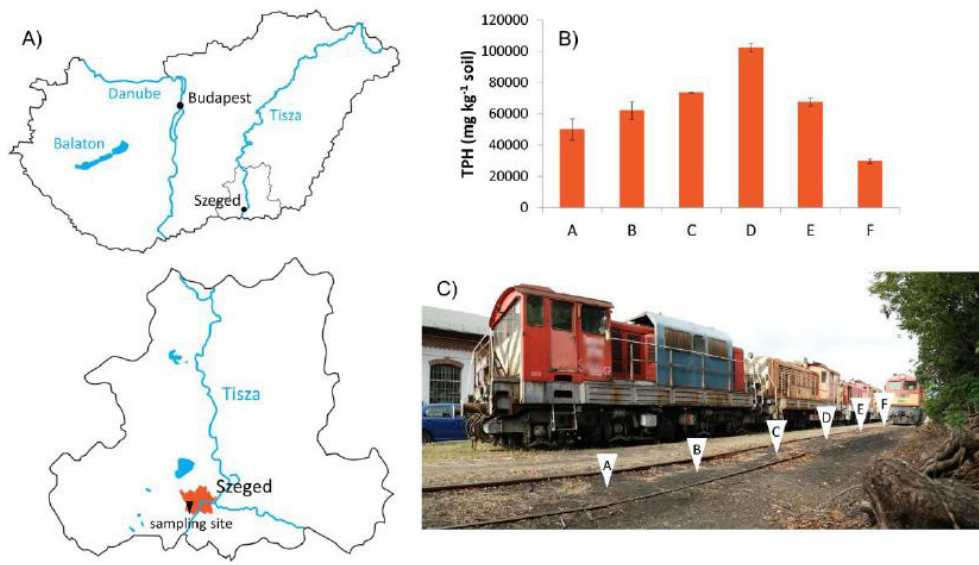
Figure 1. ( A ) Location of the used lubricant oil (ULO)-contaminated sampling site near Szeged, Hungary and ( B ) total petrol hydrocarbon (TPH) levels measured in ( C ) six sampling points of the transect.